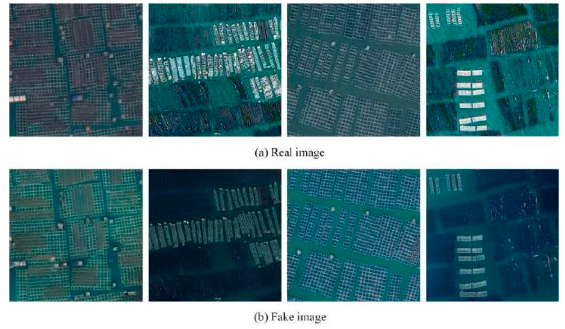
Figure 4. ( a ) Real image; ( b ) GAN-generated fake image.